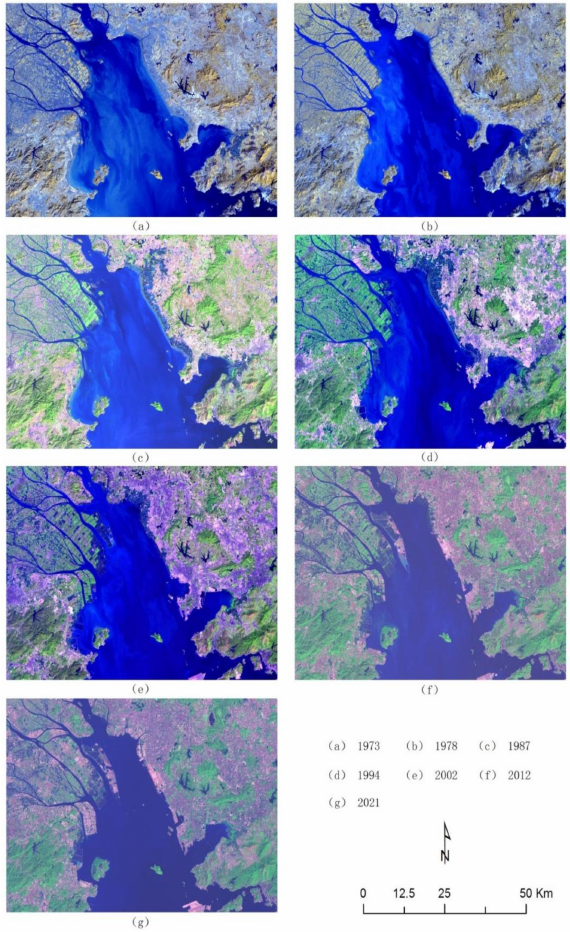
Figure 2. Satellite images in typical years in the study area (taken in 1973–2021). ( a ) 1973 remote sensed image; ( b ) 1978 remote sensed image; ( c ) 1987 remote sensed image; ( d ) 1994 remote sensed image; ( e ) 2002 remote sensed image; ( f ) 2012 remote sensed image; ( g ) 2021 remote sensed